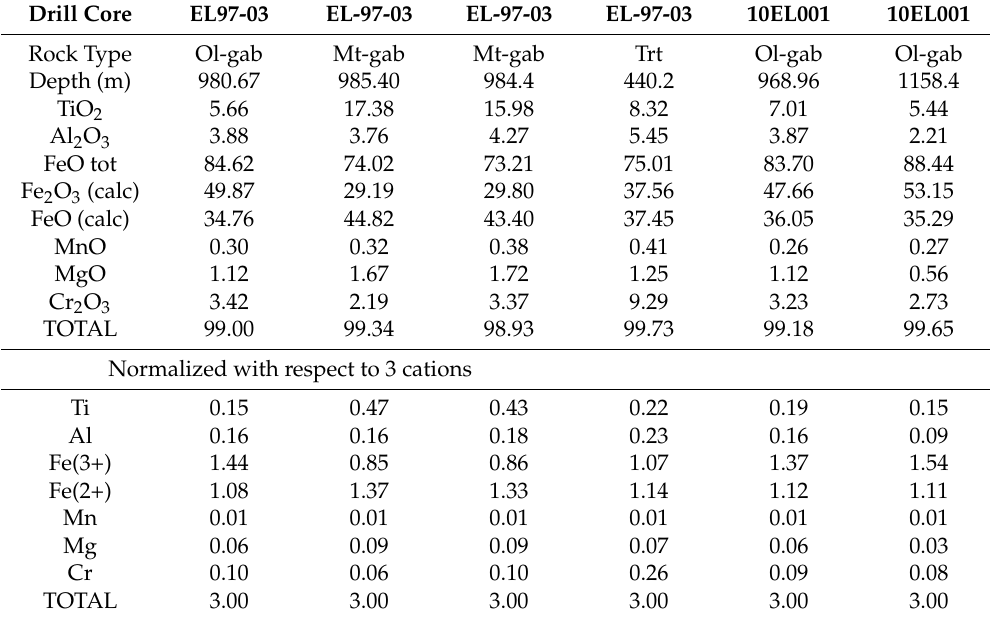
Table 5. Composition of titaniferous magnetite in major rock